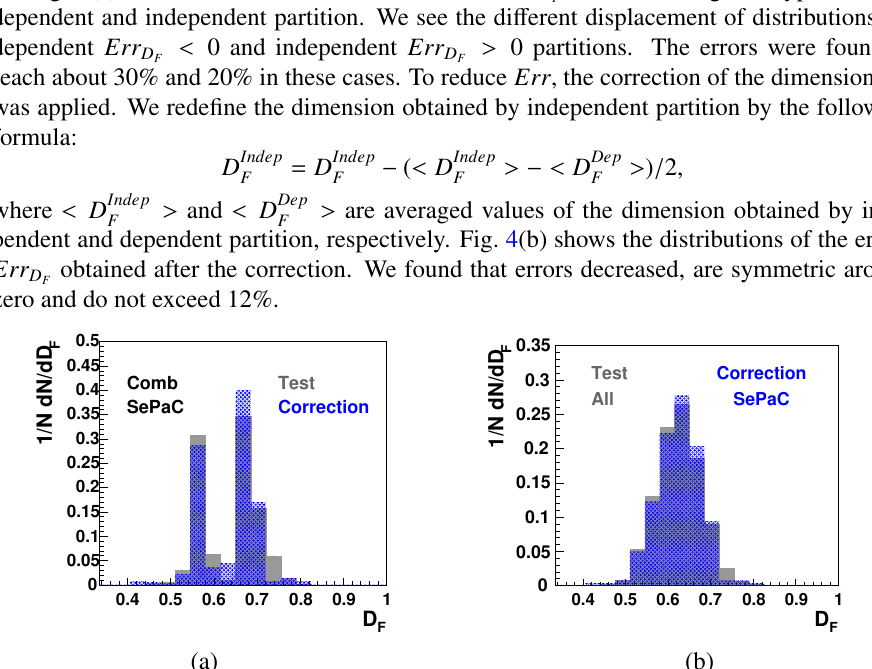
Figure 4. The event distribution by errors Err D (black area) hypotheses of the SePaC method before (a) and after corrections (b)